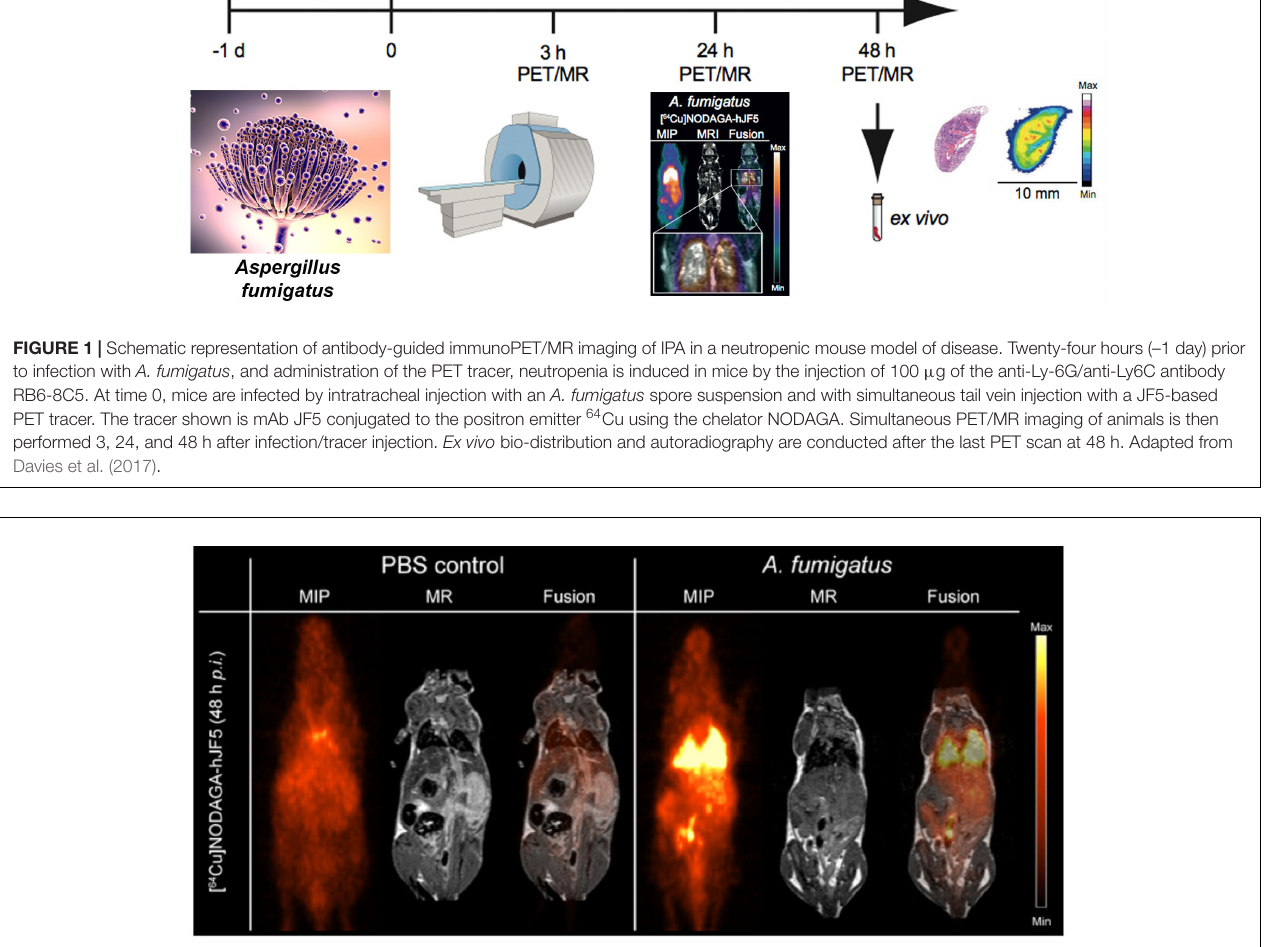
FIGURE 2 | ImmunoPET/MR imaging of IPA using the humanized Aspergillus -specific tracer [ 64 Cu]NODAGA-hJF5. The images show coronal maximum intensity projections (MIP), magnetic resonance (MR) imaging, and fused positron emission tomography (PET)/MR images of uninfected mice (PBS control) and mice infected with A. fumigatus . In order to render animals neutropenic, they received an intraperitoneal injection of the antibody RB6-8C5 and, 24 h later, were injected with the pathogen and [ 64 Cu]NODAGA-hJF5 tracer, according to the experimental procedure shown in Figure 1 . Forty-eight hours after injection with the pathogen and humanized tracer, PET/MR imaging shows specific accumulation of the tracer in A. fumigatus -infected lung tissues. Image courtesy of MATHIAS